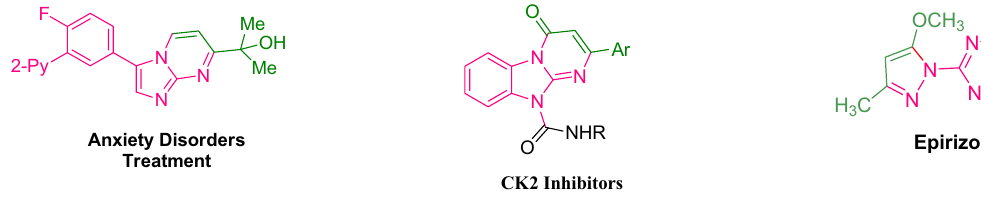
Figure 1. Representative examples of biologically active imidazopyrimidine